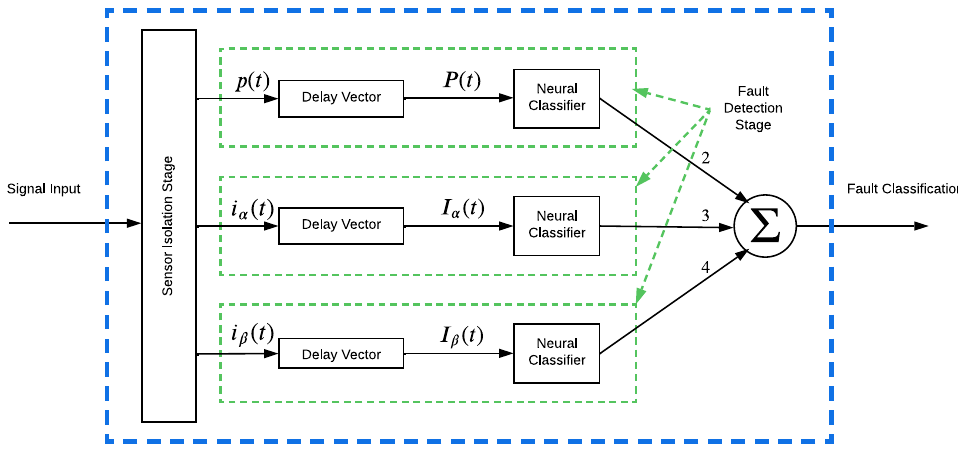
Figure 6. Configurationofallneuralnetworksusedtoclassifyfaultsofsenseddata. I α ( t ) = [ i α ( t − ( d − 1 )) ,...,